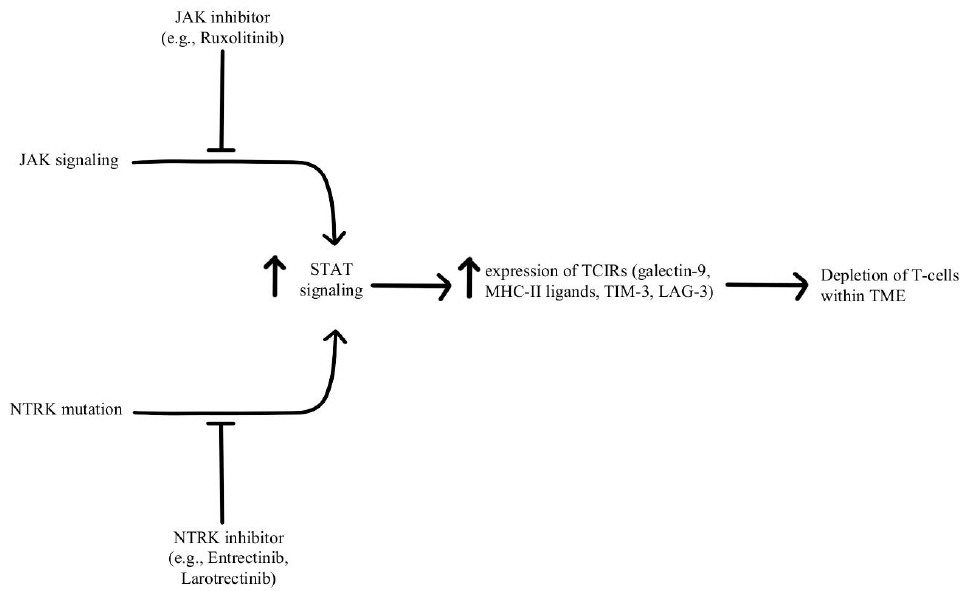
Figure 7. Diagram of STAT pathway modulation [4,96–98]. Illustrated by Kaitlyn Mi of The Dart- mouth Institute.